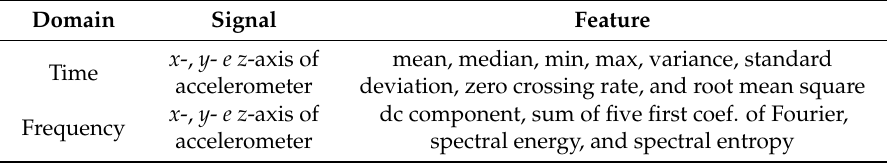
Table 2. Set of the features used in the experiments with the baseline classifiers. Domain Signal Feature x -, y - e z -axis of mean, median, min, max, variance, standard Time accelerometer deviation, zero crossing rate, and root mean square x -, y - e z -axis of dc component, sum of five first coef. of Fourier, Frequency accelerometer spectral energy, and spectral